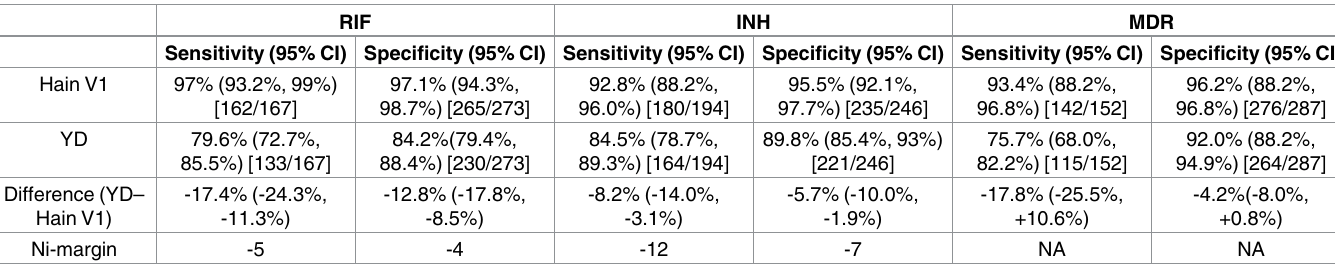
Accuracy of YD and Hain V1 compared to a phenotypic reference standard are displayed followed by the comparative difference (YD-Hain V1) and non- inferiority margins. Each comparison has the point estimate followed by the 95% confidence interval in parenthesis, ‘()’. Brackets ‘[]’ show the number of successful test runs (compared to the reference standard) divided by the total number of tests. Ni-margin is the non-inferiority margin set a priori as we are not formally comparing non-inferiority for overall MDR, they is no corresponding MDR NI-margin